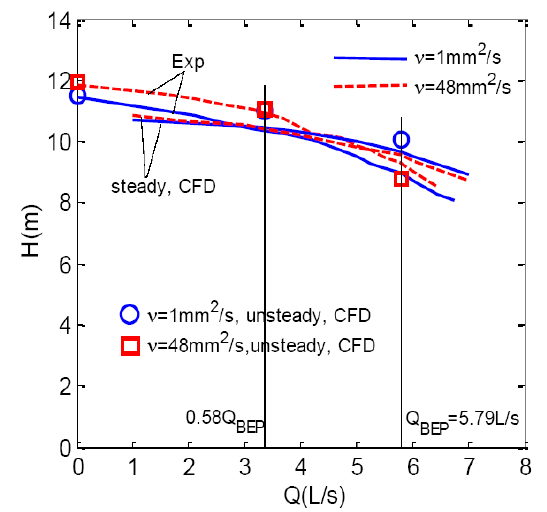
Figure 2. ComparisonofCFDpredictedpumpheadcurvewithmea- surement.